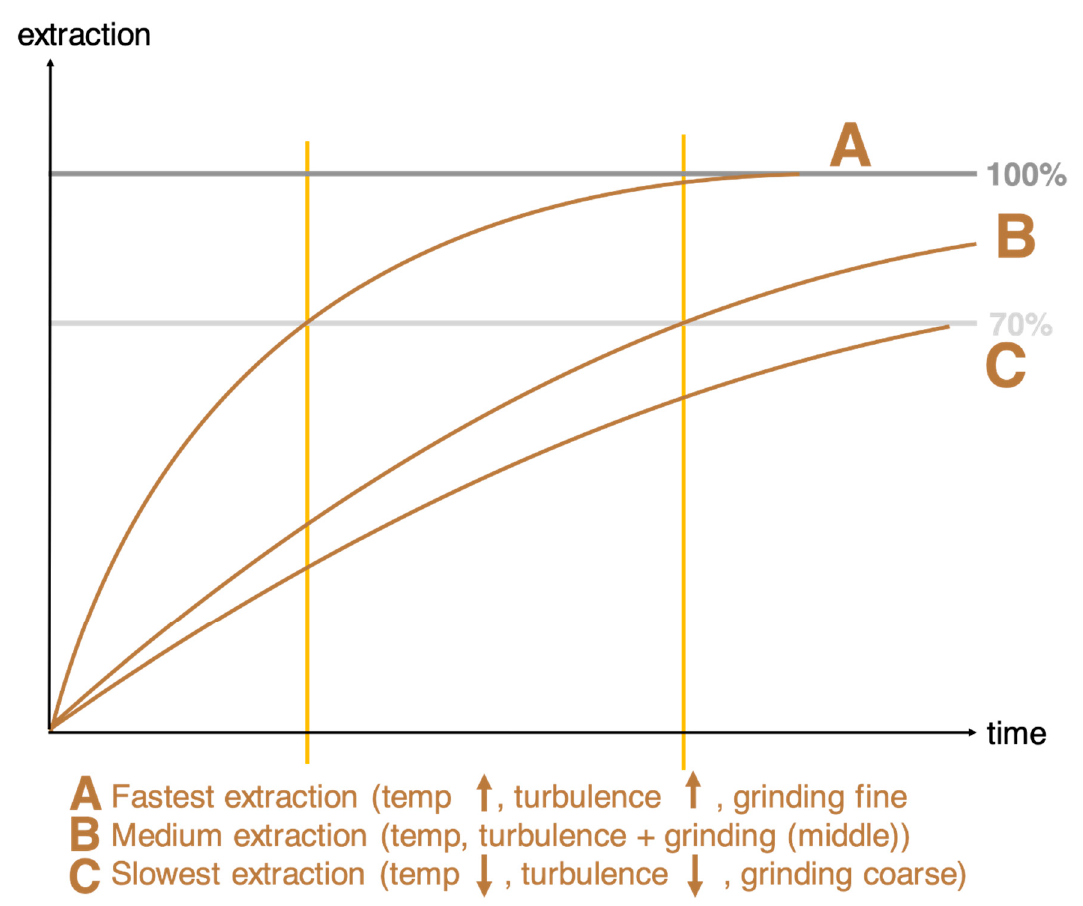
Figure 4. Model considerations about cold brew extraction.